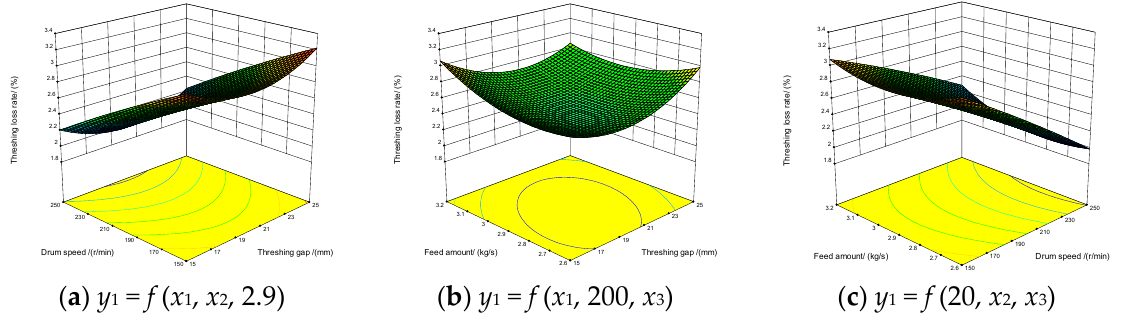
Figure 11. Influence of interactive factors on the grain loss rate.